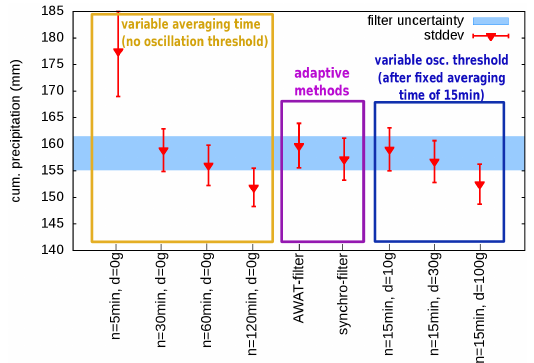
Figure 9. The values for cumulative precipitation together with the standard deviation regarding the measurements of the 18 different lysimeters for different parameter selections and the two adaptive